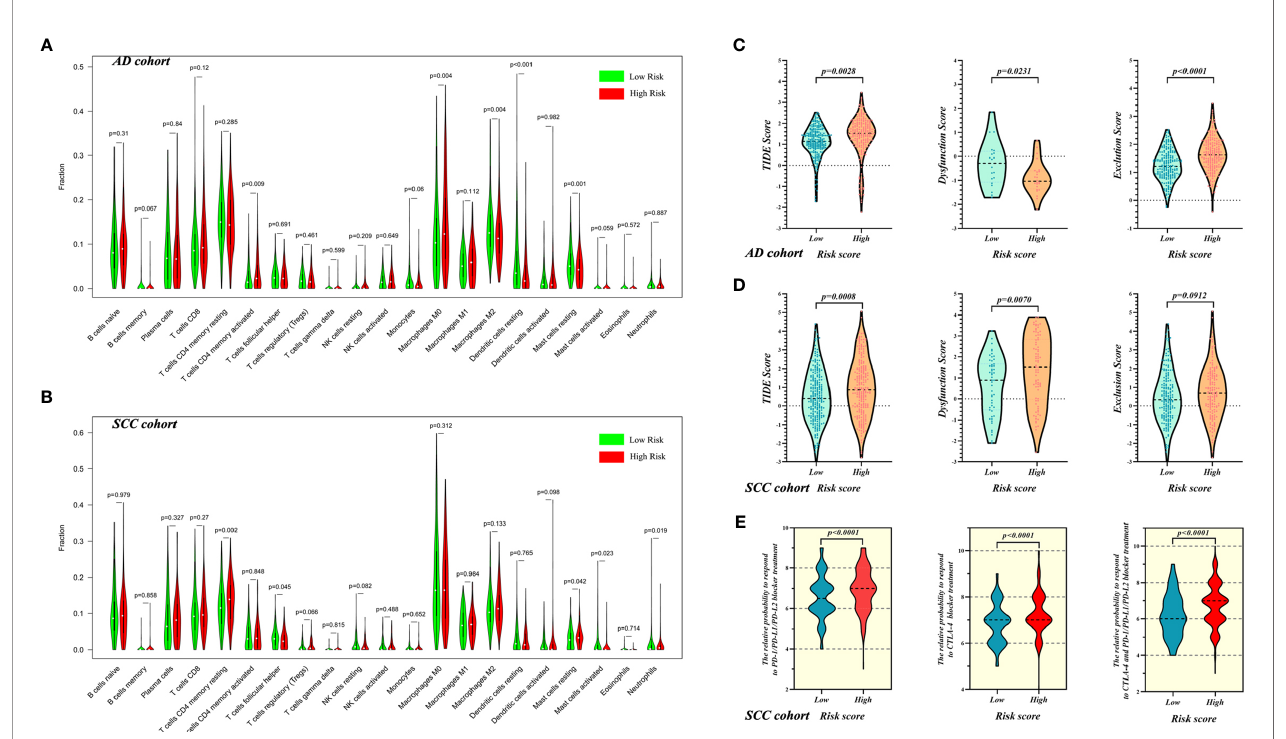
FIGURE 5 | The evaluation of immune microenvironment in high- and low-risk patients with AD and SCC. The evaluation of immune cell in fi ltration for AD cohort (A) and SCC cohort (B) . The evaluation of tumor immune microenvironment based on TIDE for AD cohort (C) and SCC cohort (D) , and the grading system contain TIDE score, T cell Dysfunction Score and Exclusion Score. (E) The prediction of response to ICI treatment for SCC patients in high- and low- risk